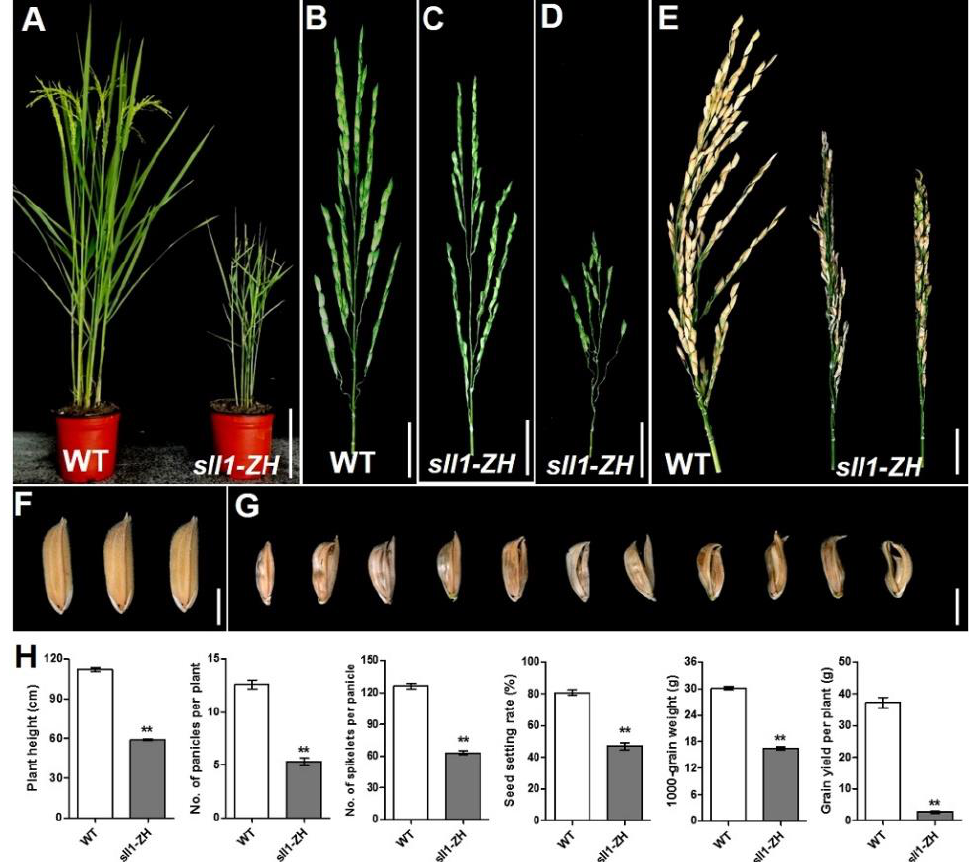
Figure 1. Phenotypic analyses of WT Zhonghui8015 (Zh8015) and the sll-ZH mutant plants. ( A ) Plant architecture of WT and the sll-ZH mutant at anthesis. Scale bar = 20 cm. ( B – D ) Panicle architecture of WT ( B ) and the sll-ZH mutant ( C,D ) at anthesis. Scale bar = 2 cm. ( E ) Panicles of WT ( left ) and the sll-ZH mutant ( right ) at maturity. Scale bar = 2 cm. ( F , G ) Morphologies of grains of WT ( F ) and the sll-ZH mutant ( G ) at the mature stage. Scale bar = 5 mm. ( H ) Comparison of yield related agronomic traits between WT and the sll-ZH mutant. ( n = 10 for plant height, No. of panicles per plant, No. of spikelet per panicle and seed setting rate; n = 5 for thousand grain weight and grain yield per plant). Data represent the means ± SD (standard deviation). The asterisks represent statistical significance determined by a Student’s t -test (** indicates significance at p ≤ 0.01). Table 1. Numbers of floral organs in spikelets of the WT Zh8015 and the SLL1-ZH mutant.